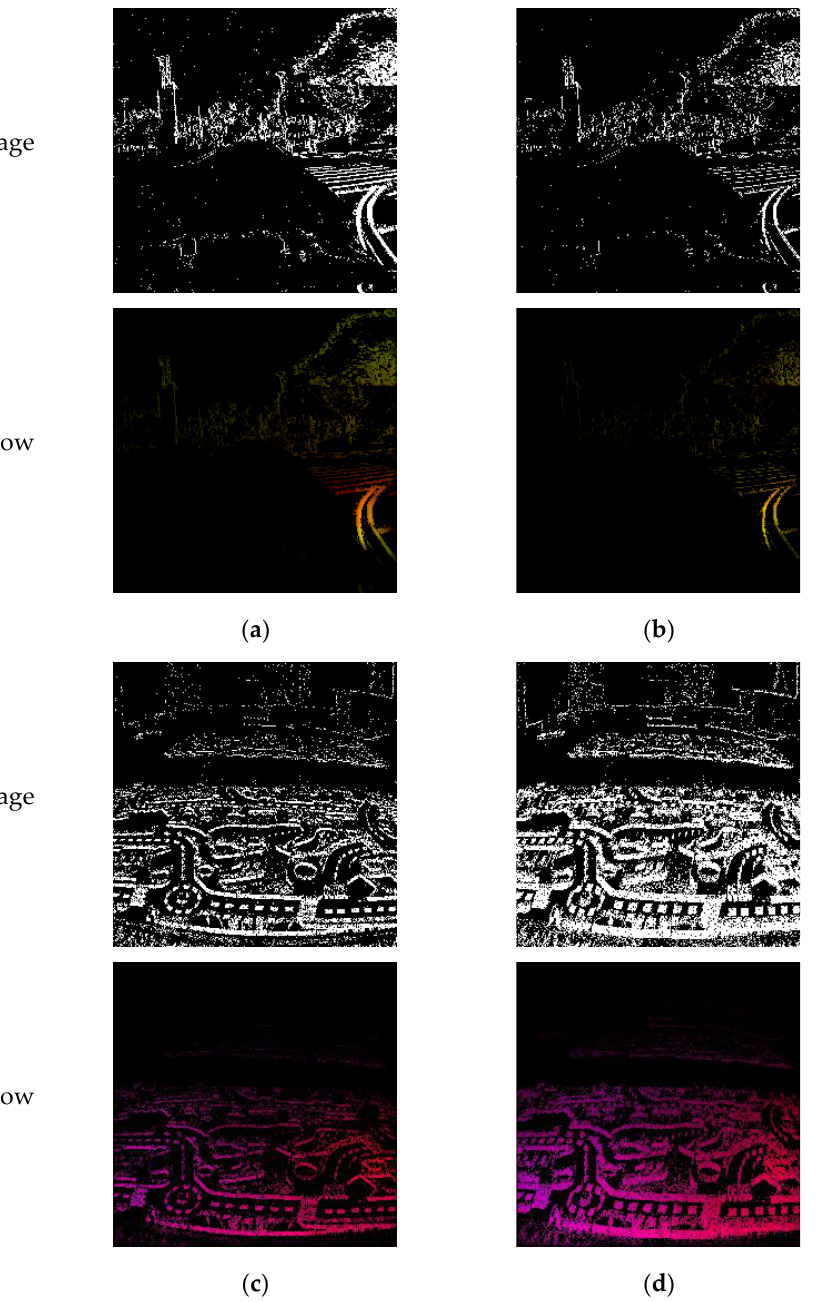
Figure 8. The optical flow prediction results after slicing by different methods. ( a ) and ( c ) do not have information loss or motion blur phenomenon by adaptive slicing compared with constant time interval; ( b ) information loss caused by constant time interval compared with adaptive slicing; ( d ) motion blur caused by constant time interval compared with adaptive slicing. ( a ) adaptive slicing, (no information loss); ( b ) constant time interval, (information loss); ( c ) adaptive slicing, (no motion blur); ( d ) constant time interval, (motion blur).